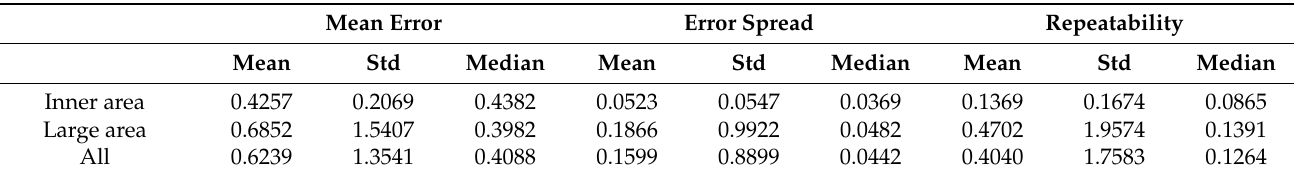
Table 1. Mean, standard deviation, and median of distance error metrics.